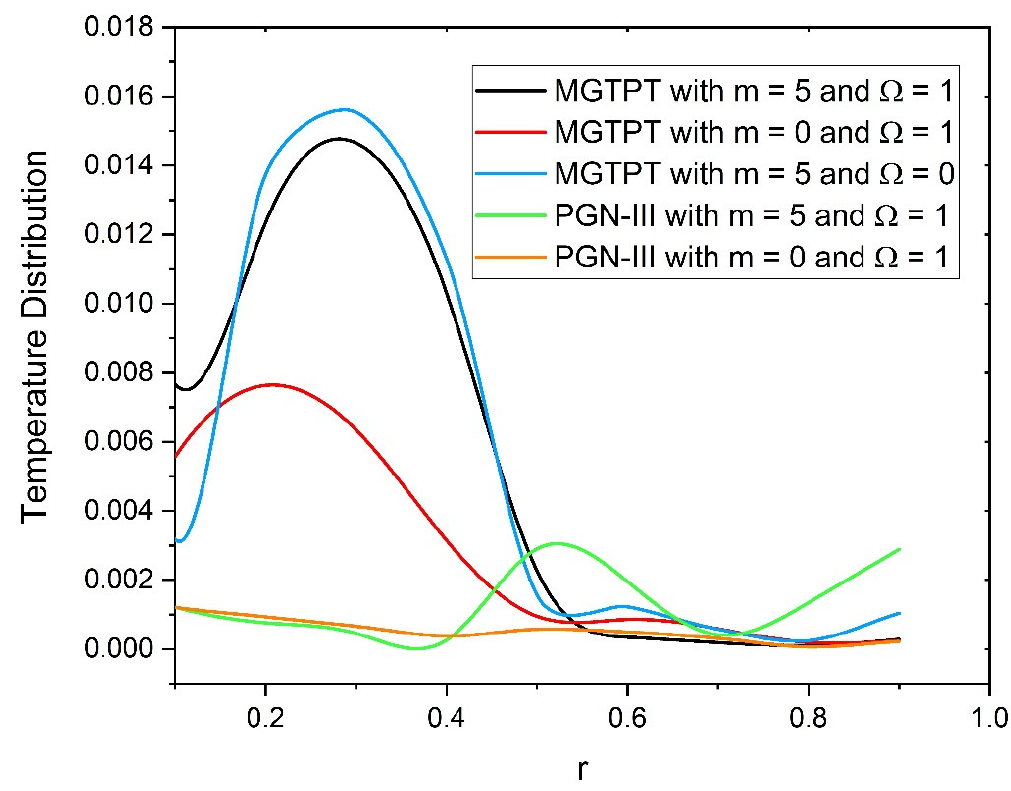
Figure 3. The temperature variation for various models with Hall effect and rotation.